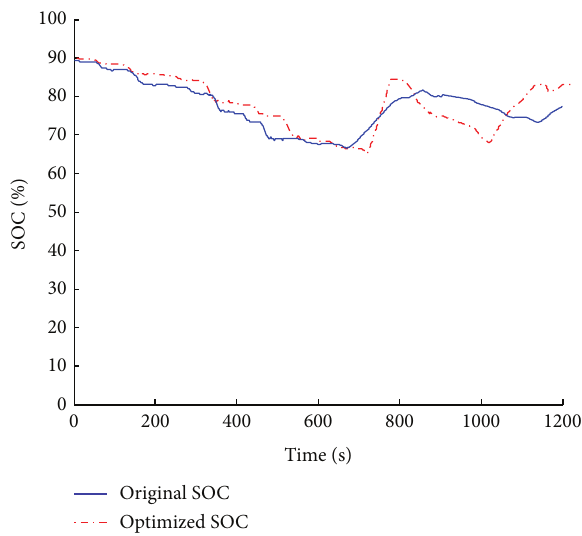
Figure 7: SOC curve of battery pack on NEDC drive